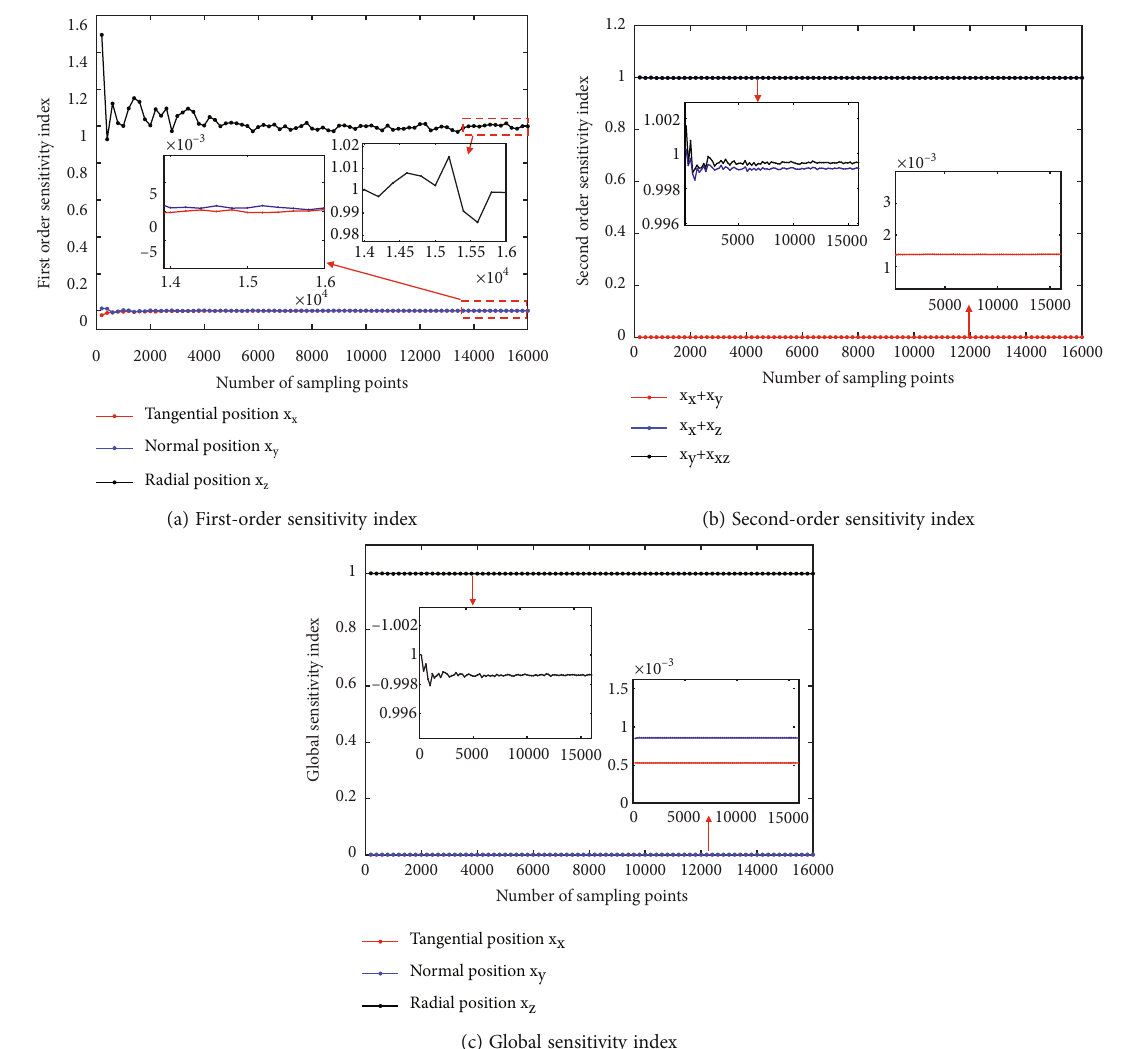
Figure 5: E ff ect of the number of sampling points on sensitivity results.